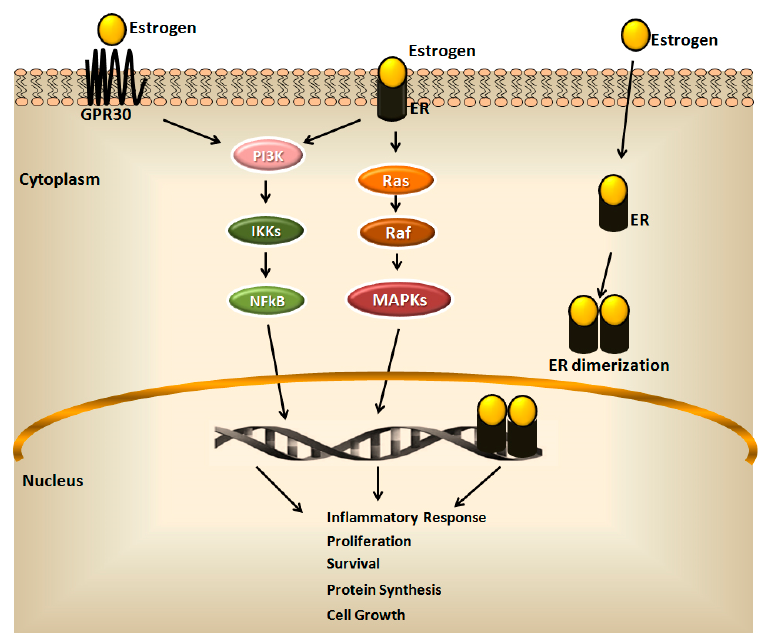
Figure 1. The estrogen signaling pathway. The estrogen signaling mainly includes activation of intracellular estrogen receptor (ER) that, upon ligand binding and dimerization, translocates to the nucleus, where it directly binds responsive elements of target genes involved in the cell growth, inflammation, proliferation, survival, and protein synthesis. Differently, estrogens mediate non-genomic effects and activate intracellular signaling through the binding of the plasma membrane receptors, ER variants and the G protein-coupled receptor (GPR30). This binding induces the rapid activation of protein kinases, phosphatidylinositol-3-kinase (PI3K), renin-angiotensin system (Ras) and rapidly accelerated fibrosarcoma (Raf), as well as the transcription factors nuclear factor kappa- light-chain-enhancer of activated B cells (NF κ B) and mitogen-activated protein kinase (MAPK), which regulate the gene expression of estrogen target genes.